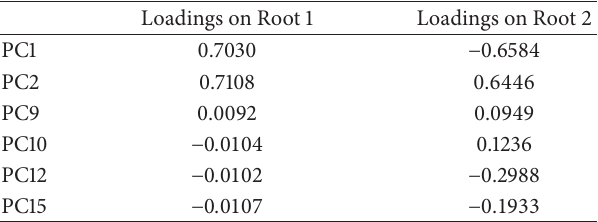
Table2:CoefficientsofthesignificantPCsincludedinthefinalLDA model on the first two canonical roots